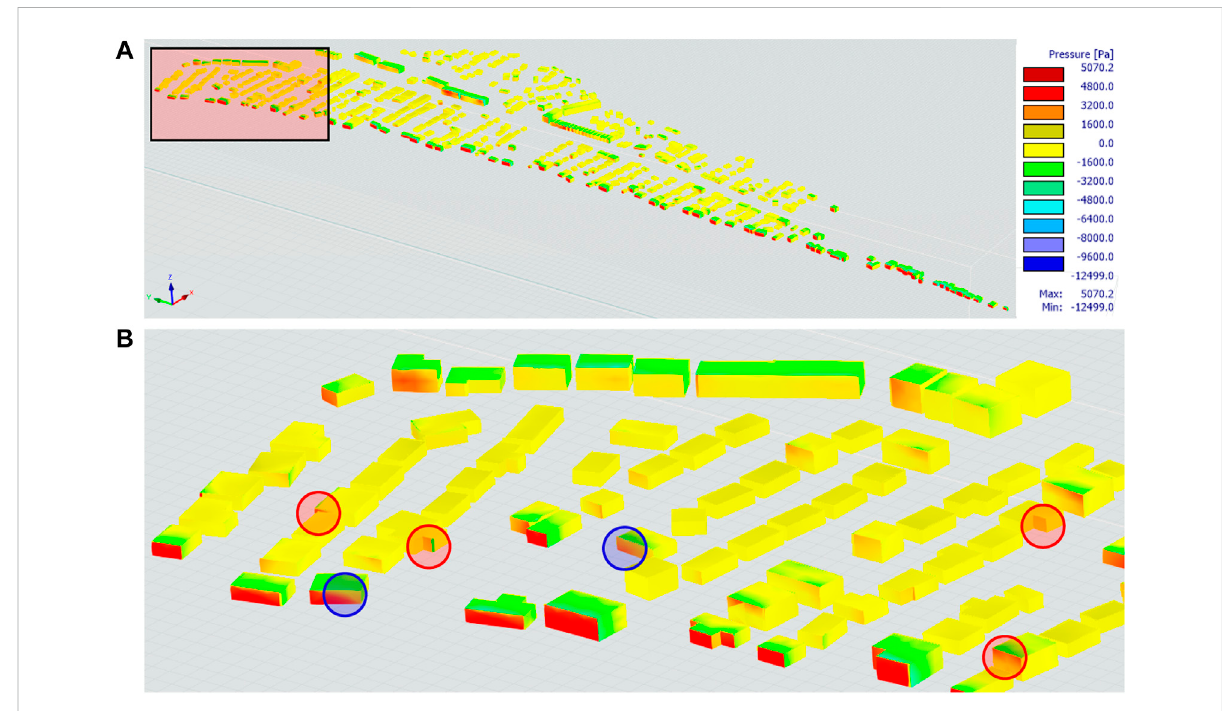
FIGURE 12 Windpressuredistribution: (A) Thedistributionofsurfacewindpressureonbuildingsacrossthecommunity; (B) Close-up viewonthebuilding- level wind press